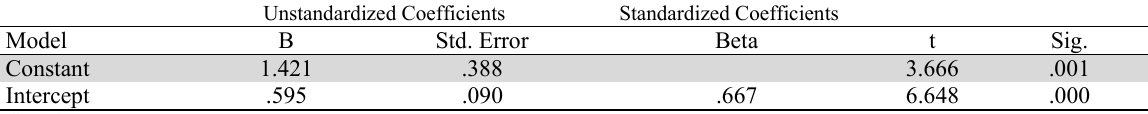
The results of the regression analysis Unstandardized